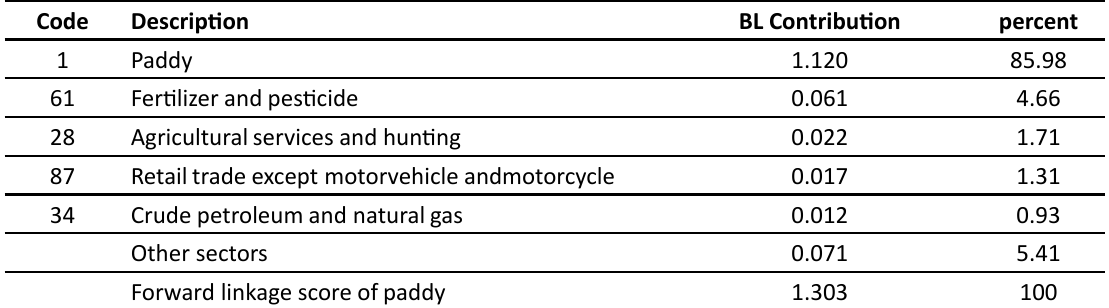
Table 2: The Big Five Contributor of BL Rice Sector